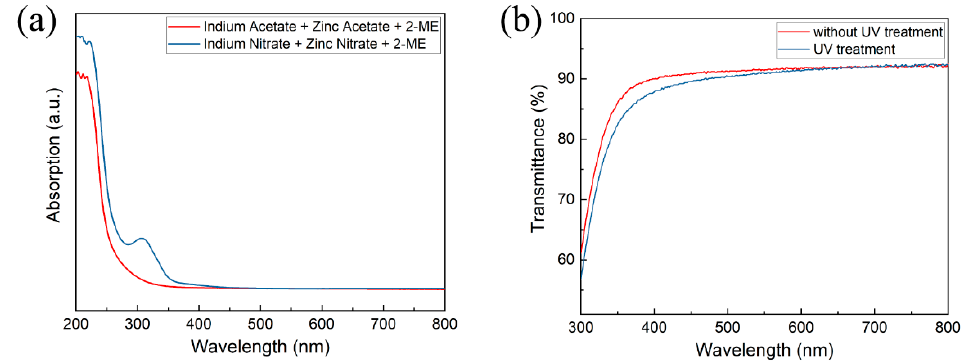
Figure 1. ( a ) The absorption spectra of different precursors solutions. ( b ) The transmittance of IZO thin films with and without UV treatment, respectively.